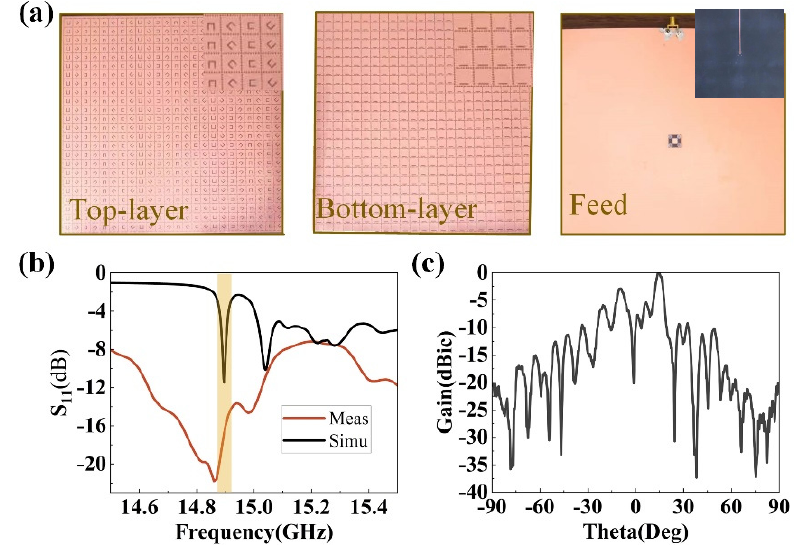
Figure 7. The measurement of the FP resonator antenna. ( a ) Experimental setup photos. ( b ) Reflection coefficients. ( c ) Radiation patterns at 14.9 GHz.